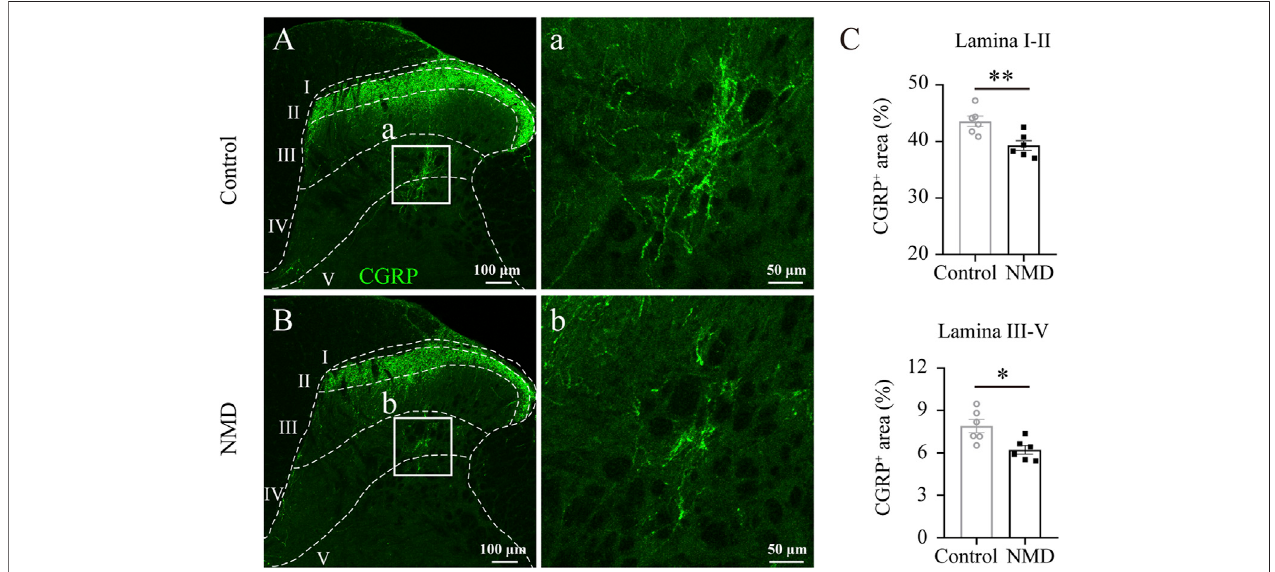
FIGURE6| Long-term administration ofNMD reduces CGRP + fi ber sproutingin thelumbar spinalcord. (A – B) Representative images ofCGRP immunostainingin theL5dorsalhornfromcontrolorNMD-treatedrats.Theboxed regionineachimageismagni fi edinthecorrespondingpanela,bshowingCGRP + fi bers. (C) Long-term treatmentwithNMDreducestheproportionalareaofCGRP + axonsinlaminaI – IIandlaminaIII – V( n (cid:1) 6ratsineachgroup). Unpairedt-test,laminaI – II,t(10) (cid:1) 3.445, p (cid:1) 0.0063; lamina III – V, t (10) (cid:1) 3.063, p (cid:1)